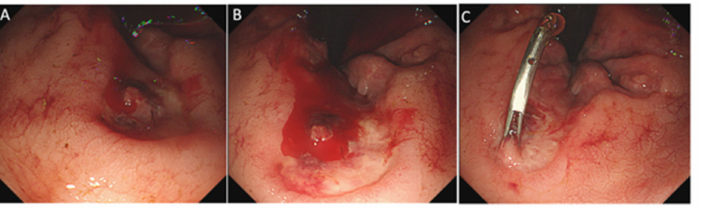
Figure 1. Endoscopic image of an acute hemorrhagic rectal ulcer. Colonoscopy revealed a solitary round rectal ulcer adjacent to the dentate line ( A ) and active bleeding with a stream of blood coming from an exposed vessel at the bottom of the ulcer ( B ). Endoscopic hemostasis was successfully achieved with clipping ( C